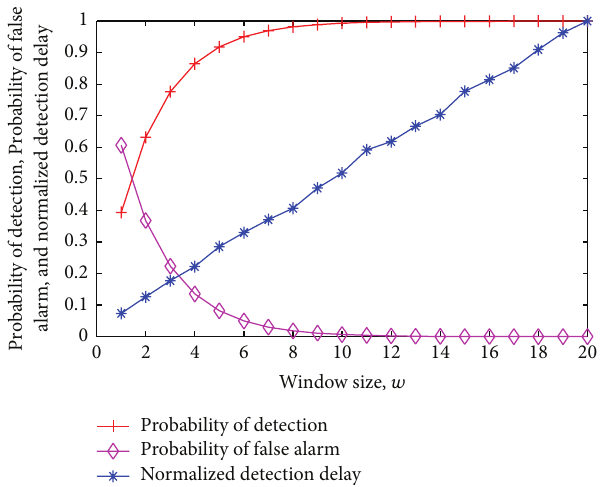
Figure 6: Variation of probability of detection, probability of false alarm, and normalized detection delay for various window